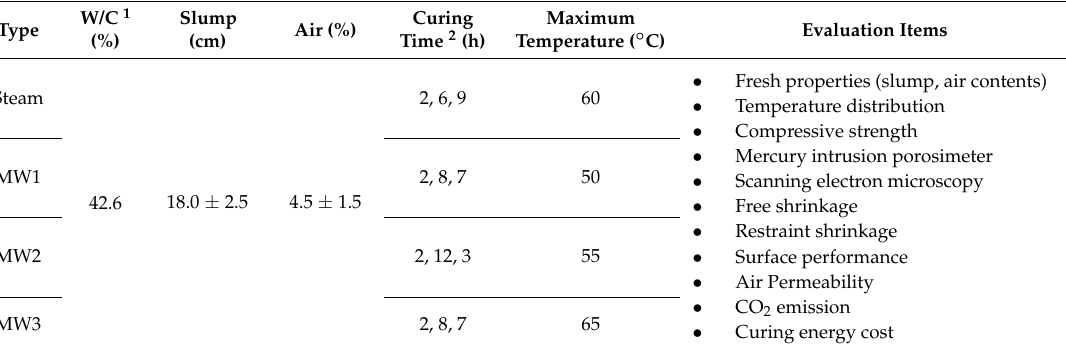
Table 1. Experimental conditions.